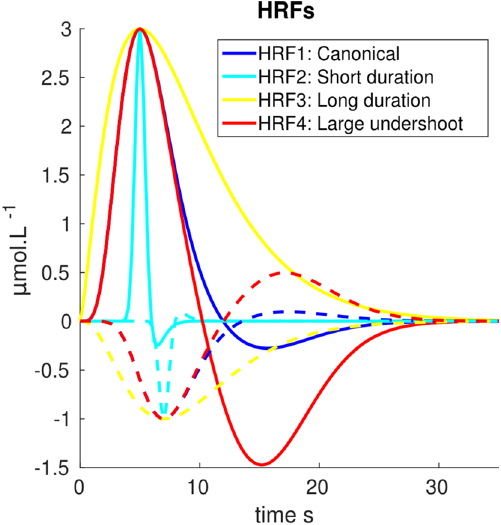
Figure 2. Simulated HRF models for HbO (plain) and HbR